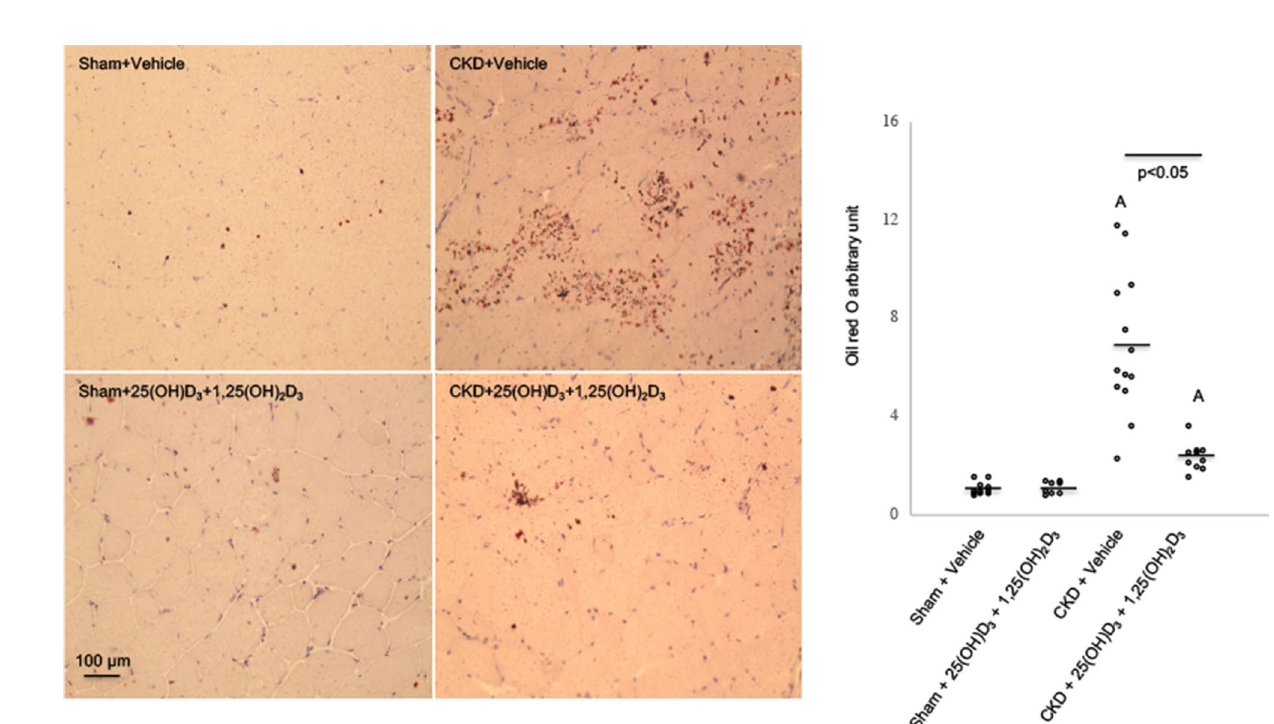
Figure 5. Vitamin D repletion attenuates muscle fat infiltration in CKD mice. Visualization and quantification of fatty infiltration by Oil Red O analysis in gastrocnemius muscle. Magnification is x20 for gastrocnemius muscle. Intensity for Oil Red O staining was recorded. Final results were expressed in arbitrary units, with one unit being the mean staining intensity in Sham + Vehicle mice. Difference among various groups of animals were analyzed as in Fig.